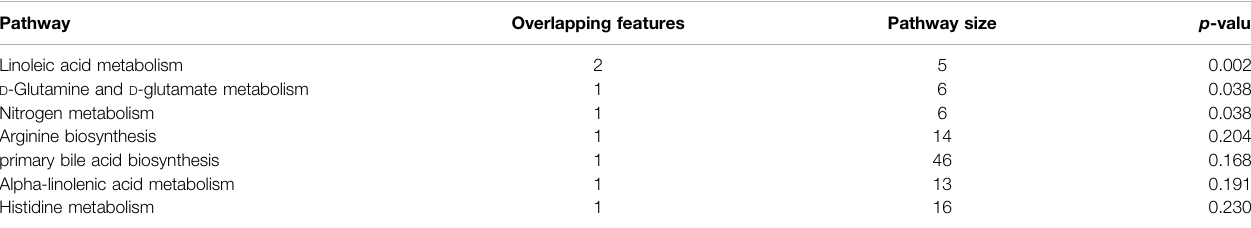
TABLE 2 | KEGG enrichment pathways altered in NPDR patients compared with T2DM patients. Pathway